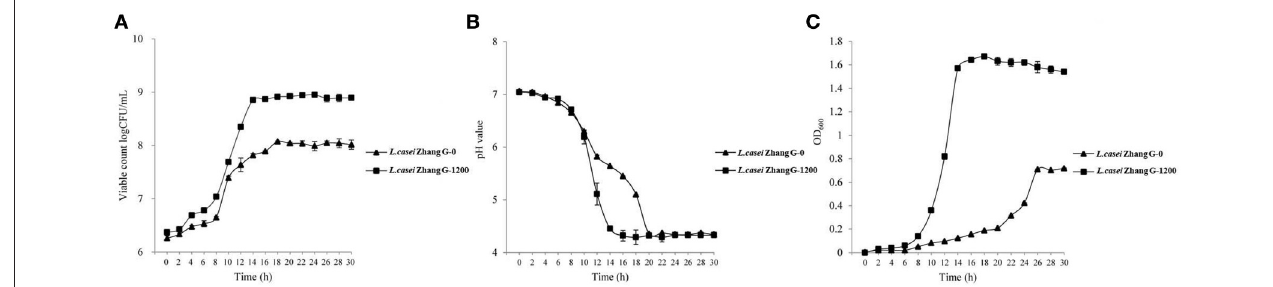
FIGURE 1 | Growth curves of the parental and L. casei Zhang-G-1200 strains based on viable counts (A) , pH values (B) and OD values (C) in gentamycin-containing